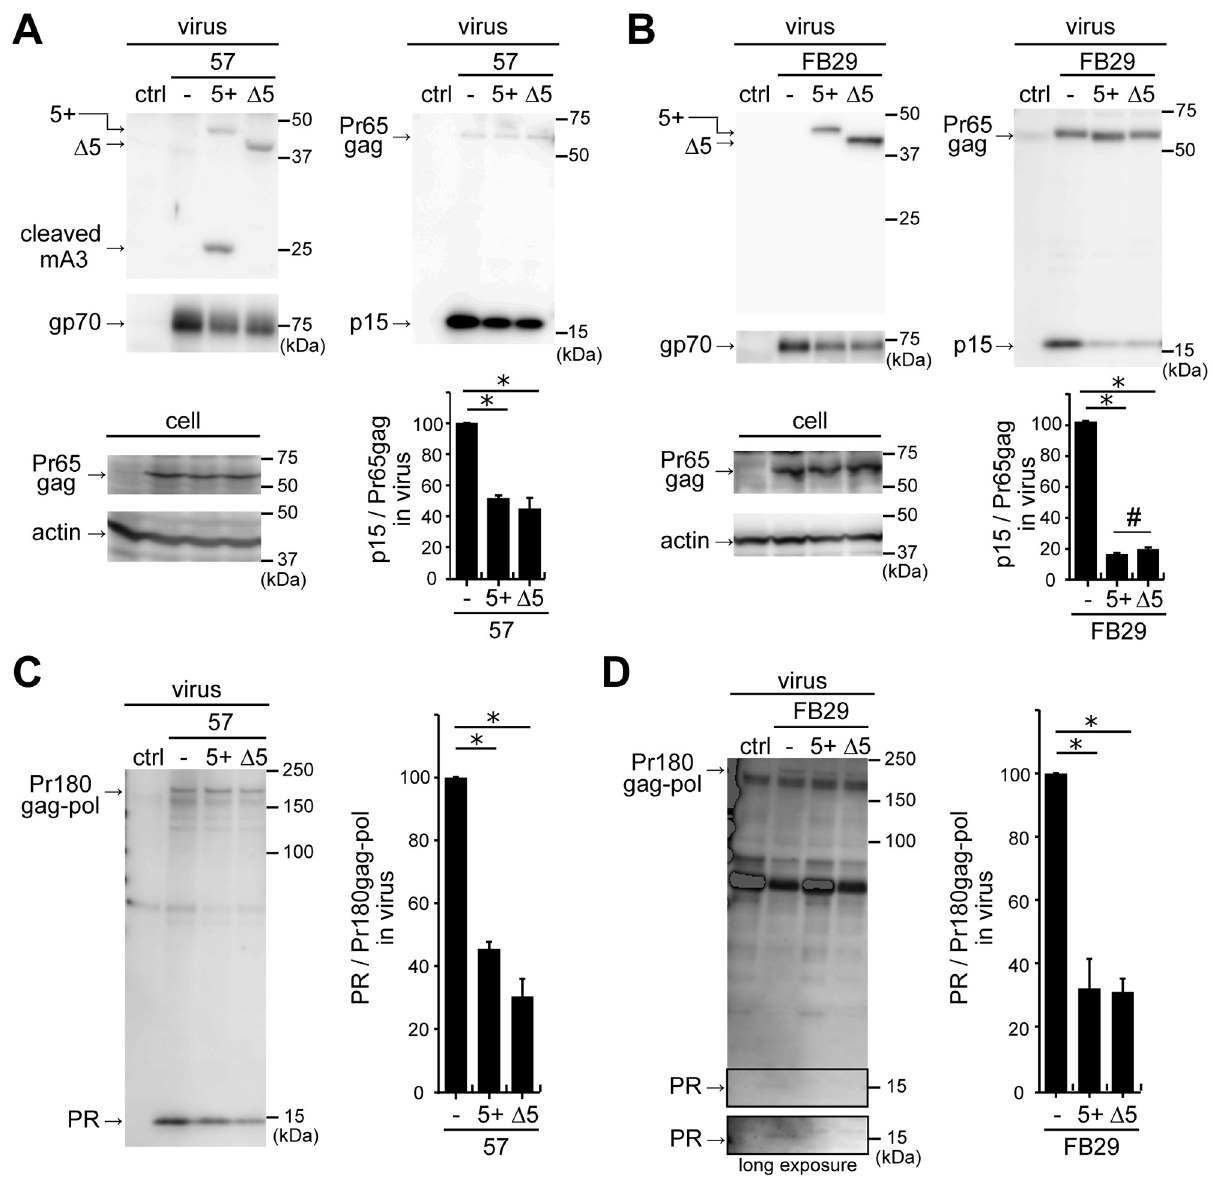
Fig 3. Virus-incorporated mA3 perturbs autocatalytic Pr180gag-pol cleavage and inhibits Pr65gag processing. (A) A comparison of Pr65gag processing patterns in the presence and absence of mA3. Strain 57 viruses were generated in the presence (5+ or Δ 5) or absence ( − ) of mA3. The virions and cell lysates were analyzed by immunoblotting. Anti-p15 (MA) mAb clone 690, anti-F-MuLV gp70 (SU) mAb clone 720, anti-FLAG mAb M2, and anti-actin Ab C-11 were used to visualize p15 and Pr65gag, gp70, mA3, and cellular actin, respectively. Band intensities of p15 and Pr65gag on the same blot were measured and p15/Pr65gag ratios were calculated. The data represent means with standard errors from three independent experiments. � , P < 0.001 by one-way ANOVA with Tukey’s multiple comparison tests. (B) The same experiments as described for panel A except that FB29 was used. � , P < 0.001; #, P < 0.05 by one-way ANOVA with Tukey’s multiple comparison tests. (C and D) The same virus lysates were used as shown in panels A and B to detect mature viral protease and its precursor, Pr180gag-pol. The rabbit anti-MuLV protease Ab was used for immunoblotting. The image taken with a long exposure time for the detection of mature viral protease within FB29 virions was also shown. Band intensities of mature viral protease and Pr180gag-pol were measured on the same blot, and PR/Pr180gag-pol ratios were calculated. The data represent means with standard errors from three independent experiments. � , P < 0.001 by one-way ANOVA with Tukey’s multiple comparison tests.